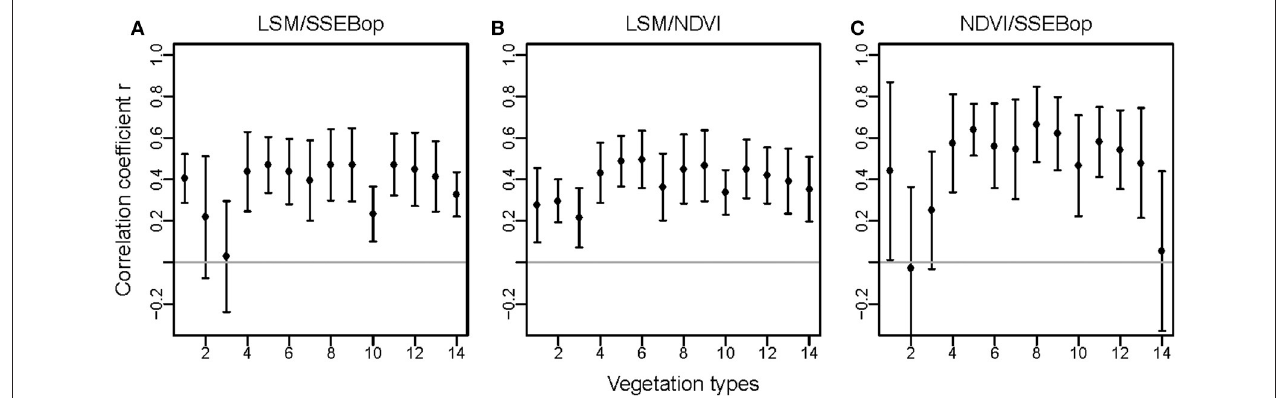
FIGURE 8 | The average correlation for the 2003–2016 by IGBP land cover types for (A) LSM ET/SSEBop ET, (B) LSM ET/NDVI, and (C) NDVI/SSEBop